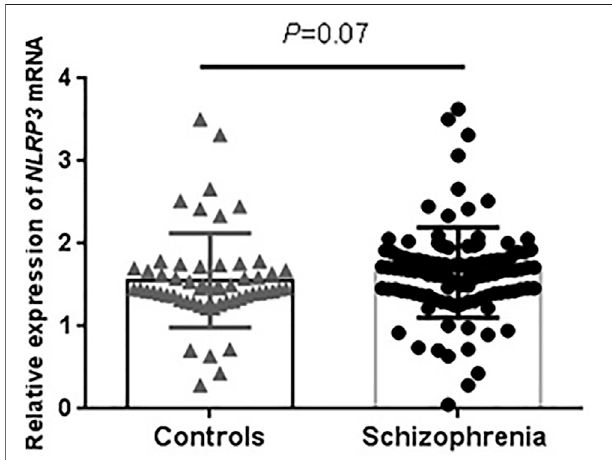
FIGURE 1 | Peripheral expression levels of NLRP3 mRNA in drug-naïve patients with fi rst-episode schizophrenia and healthy controls. NLRP3 mRNA level was normalized to that of GAPDH. Schizophrenia group ( n (cid:1) 53); Control group ( n (cid:1) 56).